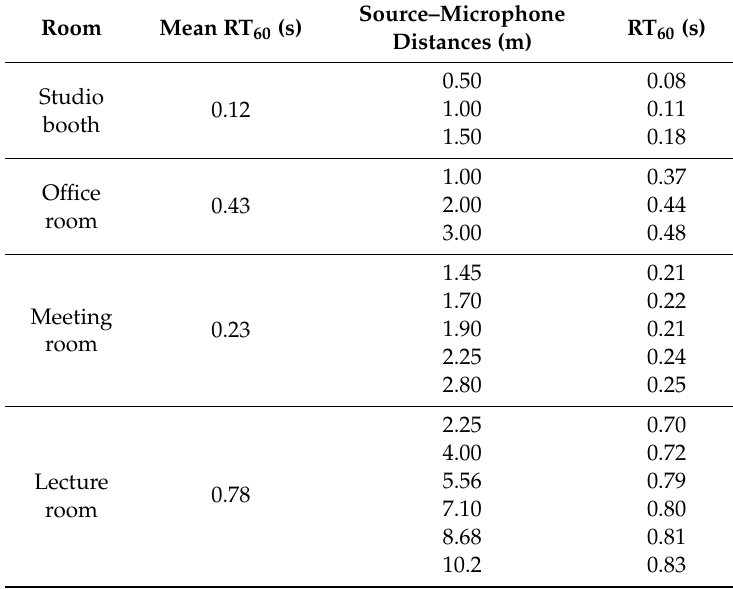
Table 4. Mean RT 60 , source–microphone distance classes for each of the four rooms and their distance-specific RT 60 values.